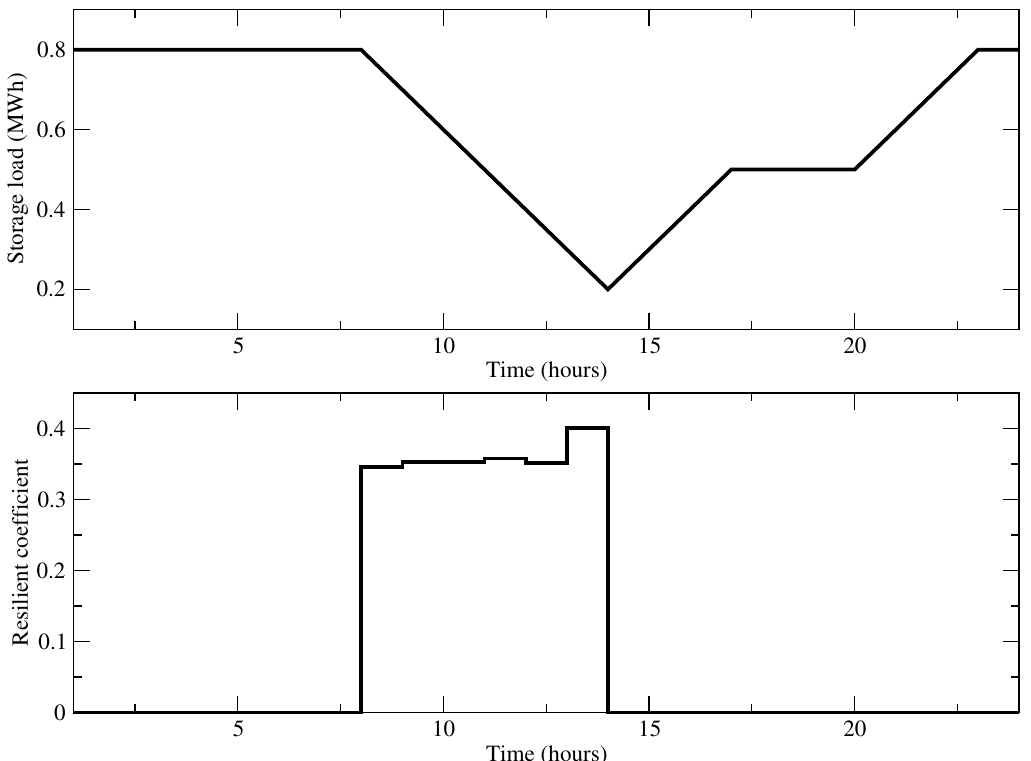
Figure 5. Top panel: the state of charge (SOC) in energy storage system (ESS) during an outage; bottom panel: the resilience distribution of the system following an